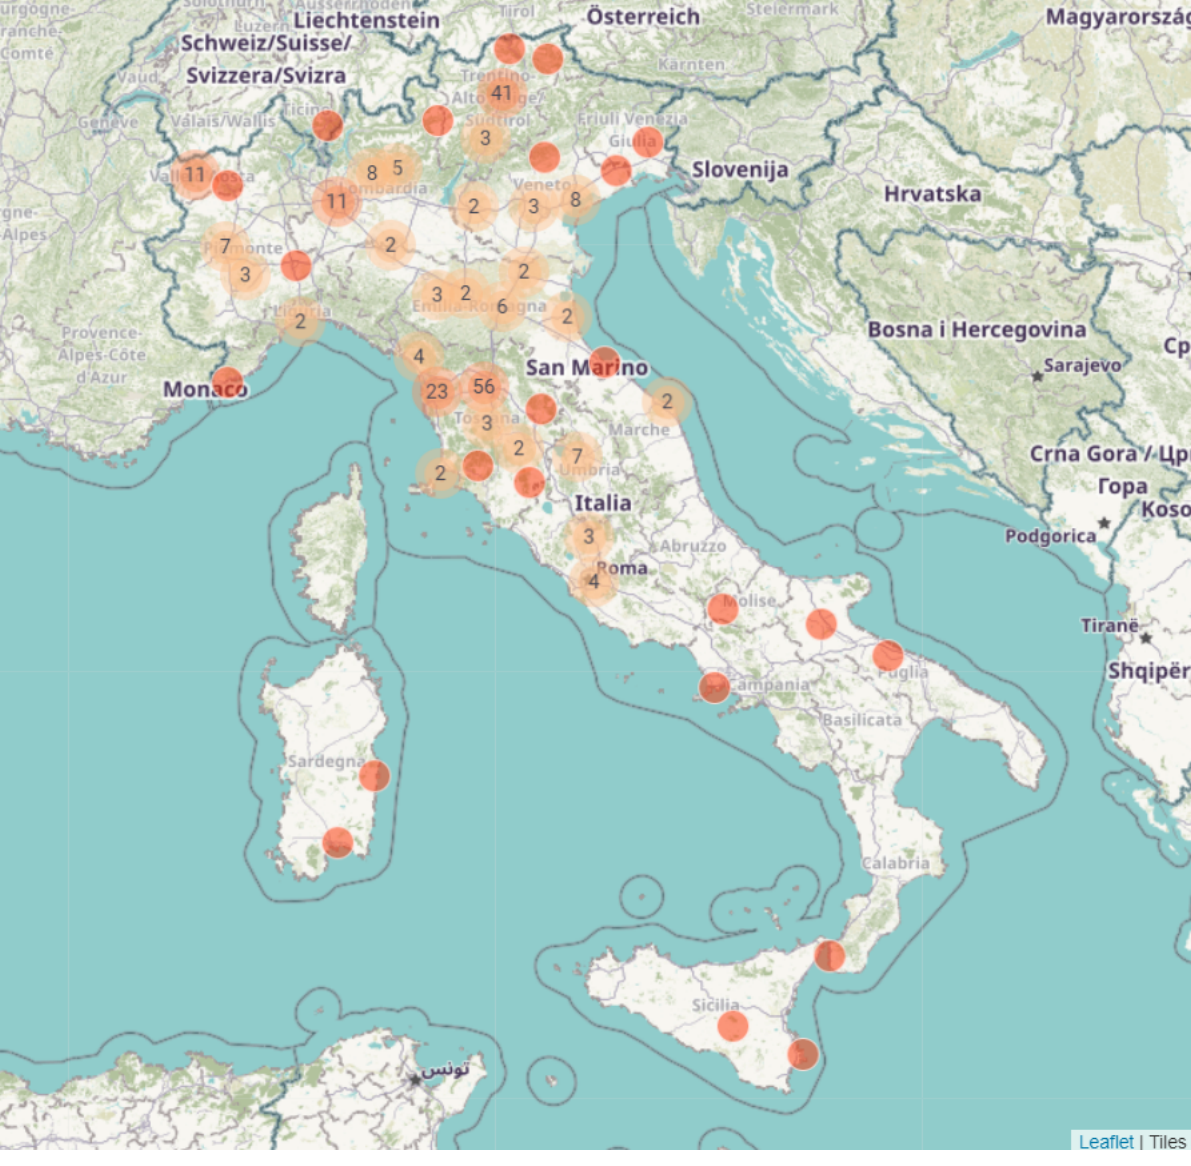
Figure 1: Distribution of people who filled in the questionnaire in